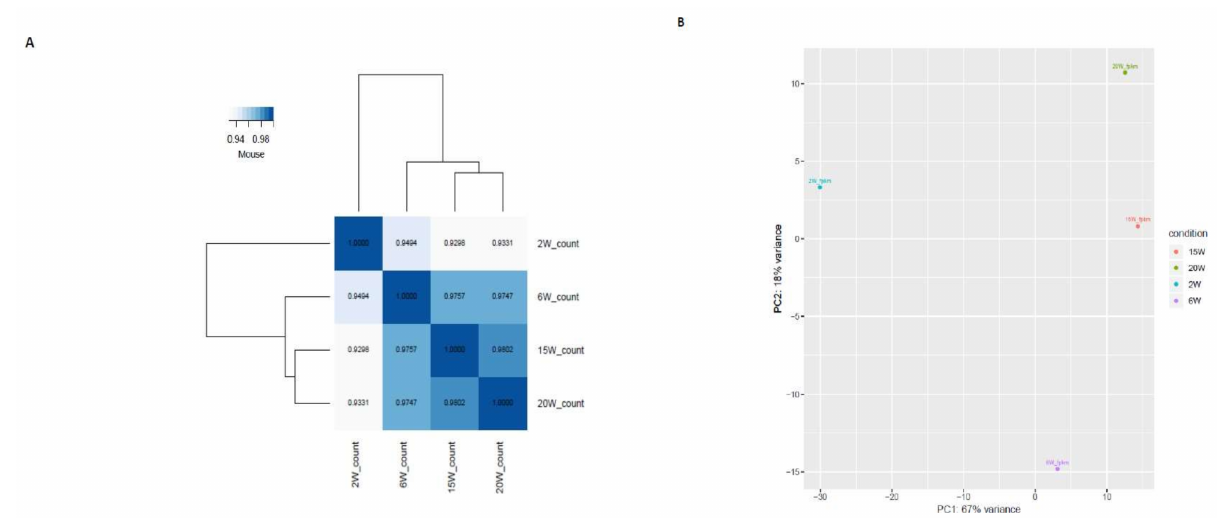
Figure 2. Correlation among analyzed genes in the reproductively aged mouse ovary. ( A ) Count data and correlation among each ovary stage, indicated by based on a heatmap, ( B ) Count data indicated by a PCA plot.